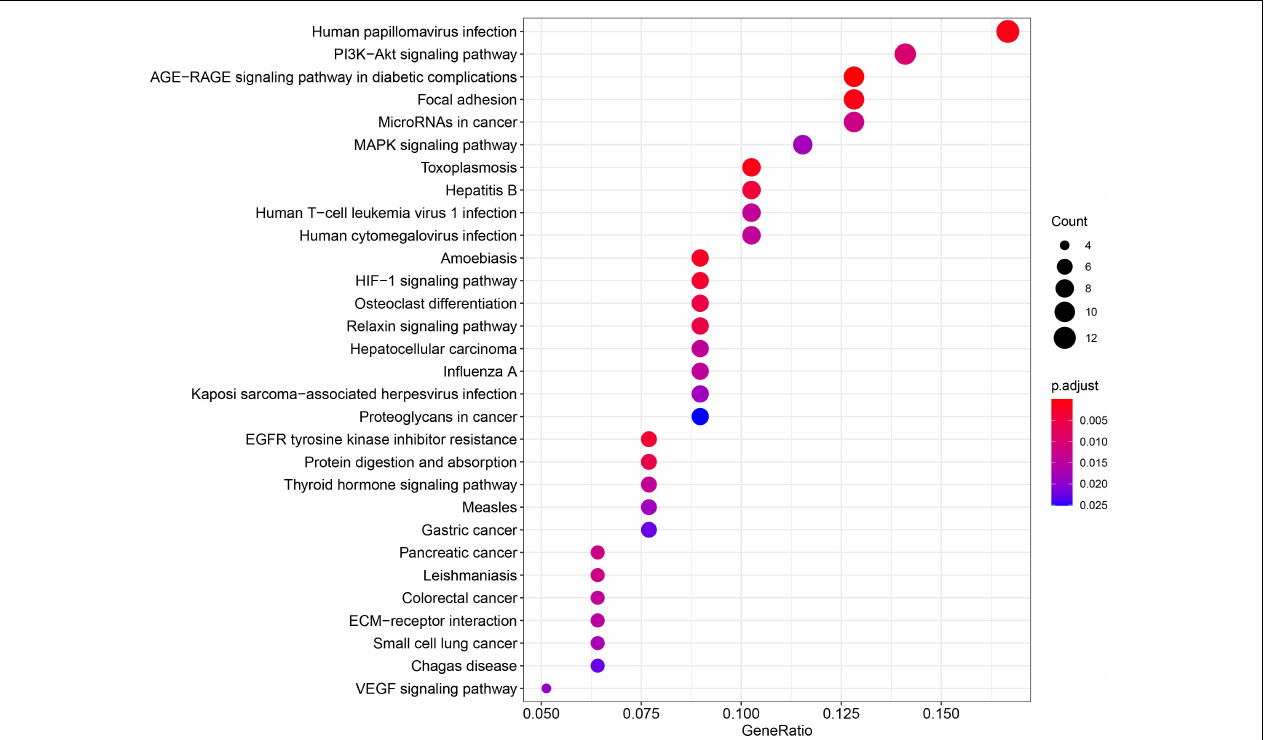
FIGURE 6 | The predicted 6-miRNA target genes were mainly enriched in virus infection pathways and cancer-related